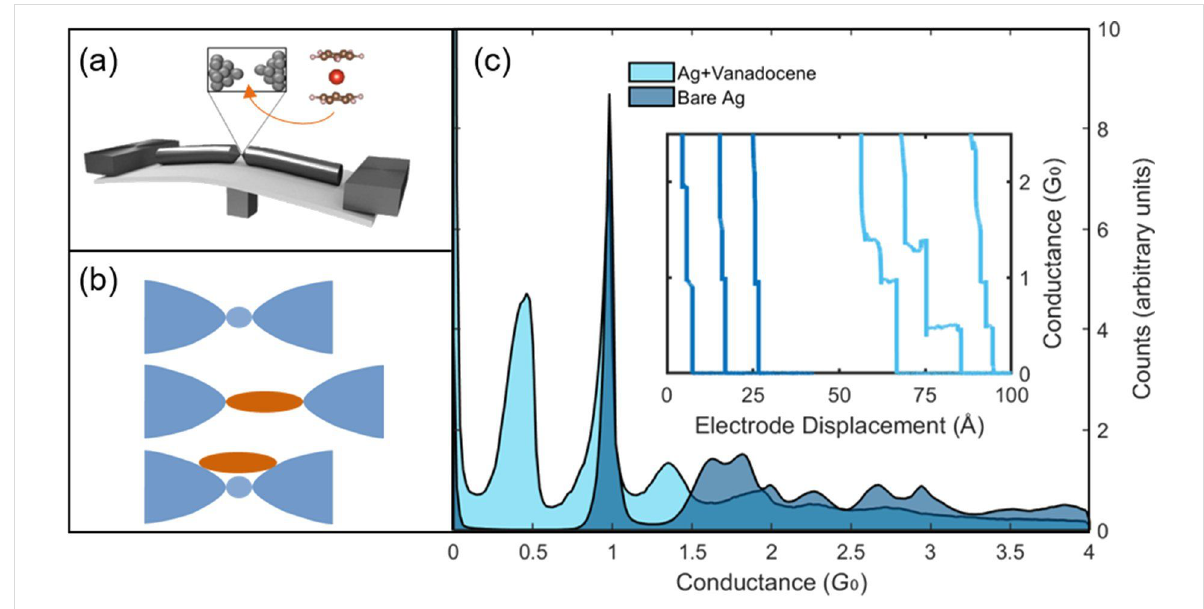
Figure 1: (a) Schematic of a mechanically controllable break junction device. Inset: Schematic of a vanadocene molecule and a broken junction. (b) Schematic illustration of a single-atom junction (top), a single-molecule junction (middle), and parallel single-atom and single-molecule junctions (bottom). (c) Conductance histograms, indicating the most probable conductance of the Ag junction during the final stages of junction elongation before (blue) and after (light blue) the introduction of vanadocene. Both histograms were taken at a bias voltage of 100 mV. Each histogram is composed from 10,000 conductance traces. Inset: Examples for conductance vs electrode displacement traces measured while elongating the atomic (blue, left) and molecular (light blue, right) junctions. The traces are shifted for